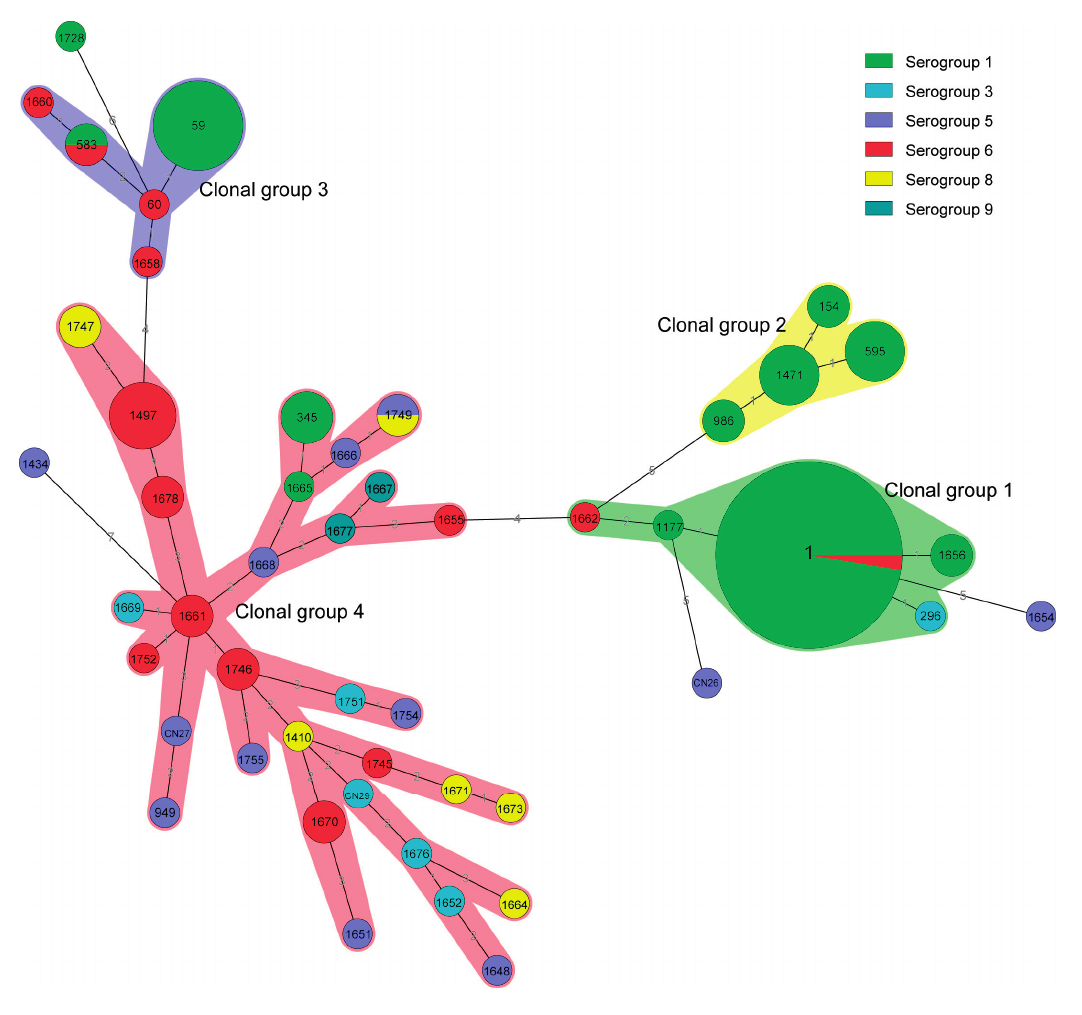
Figure 3. Minimum spanning tree analysis of 117 Legionella pneumophila isolates from industrial cooling towers in Shijiazhang, China. In the minimum spanning tree, the sequence types (STs) are displayed as circles. The size of each circle indicates the number of isolates within this particular type, and the STs are shown in the circles. The colors of the halo surrounding the STs denote types that belong to the same clonal